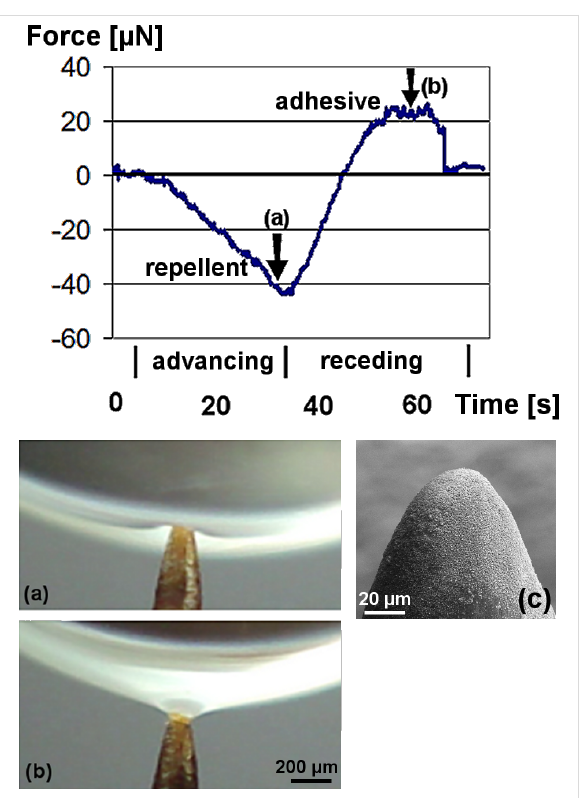
Figure 5: Measured forces between a superhydrophobic papilla-model and a water drop during advancing and receding. The images corres- ponding to the marks (arrows) in the diagram show the repellent (a) and adhesive (b) meniscus. (c) Papilla-model tip shown with